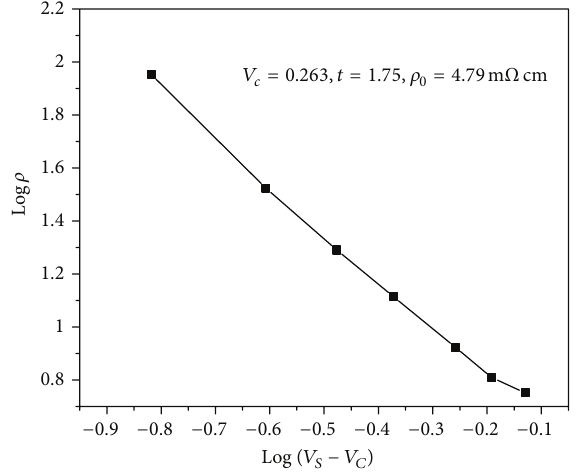
Figure 7: Log-log plot of 𝜌 versus ( 𝑉 𝑆 − 𝑉 𝐶 ).